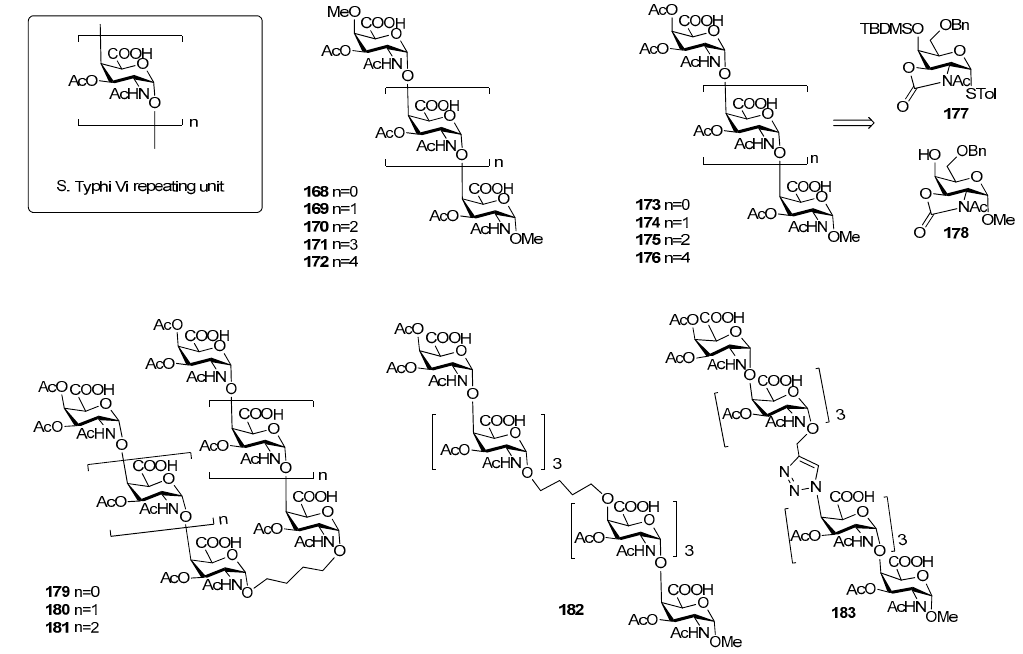
Figure 20. Repeating unit of S. Typhi Vi CPS and synthetic fragments reported in